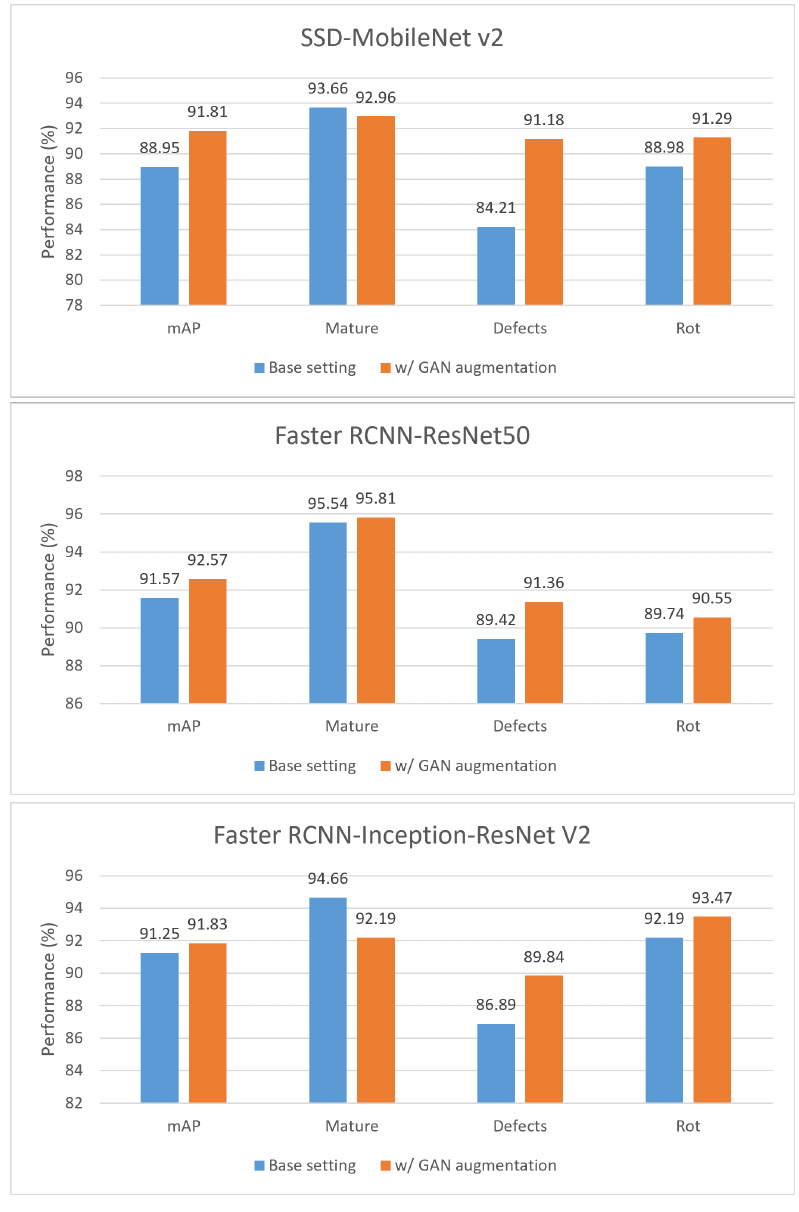
Figure 8. MAP comparison of the three models for the three lychee